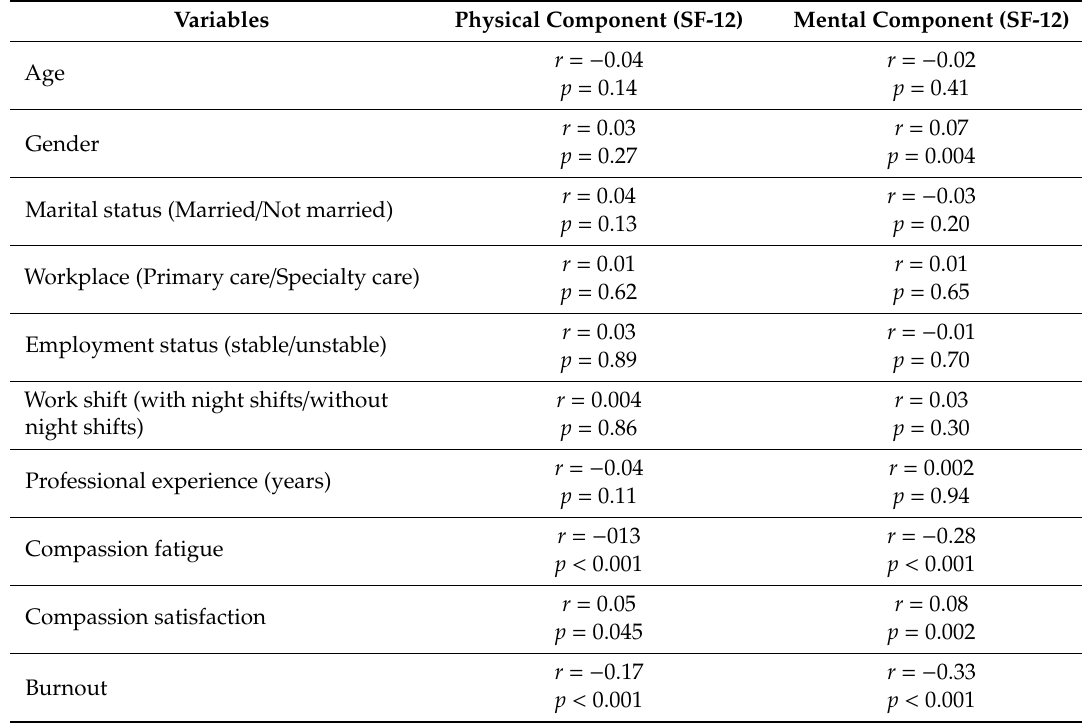
Table 3. Bivariate correlations between HRQoL and sociodemographic and work-related variables of the nurses ( n = 1521).